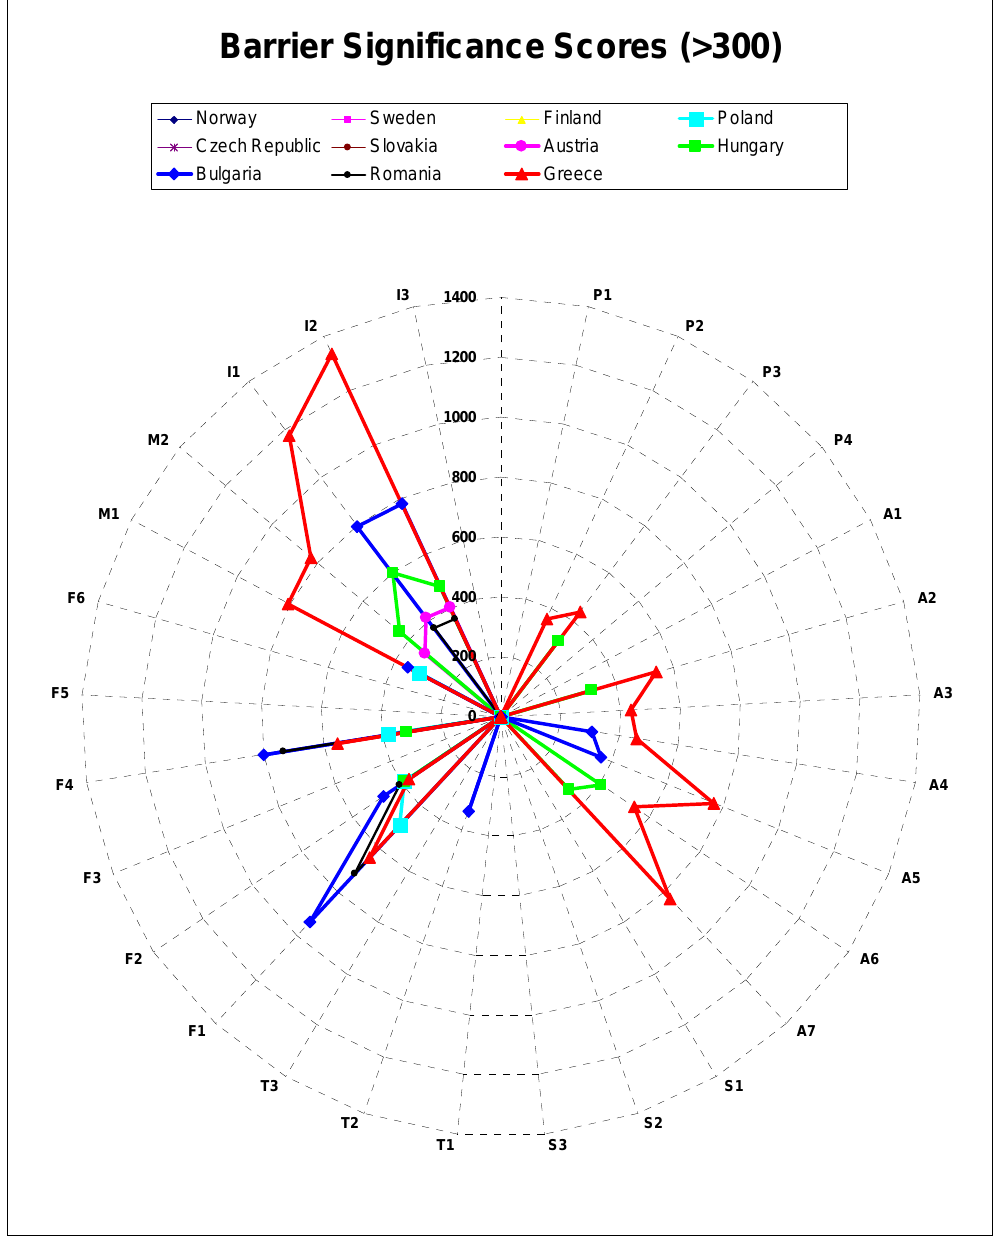
Figure 7. Barrier Significance Scores > 300 (for all implementation